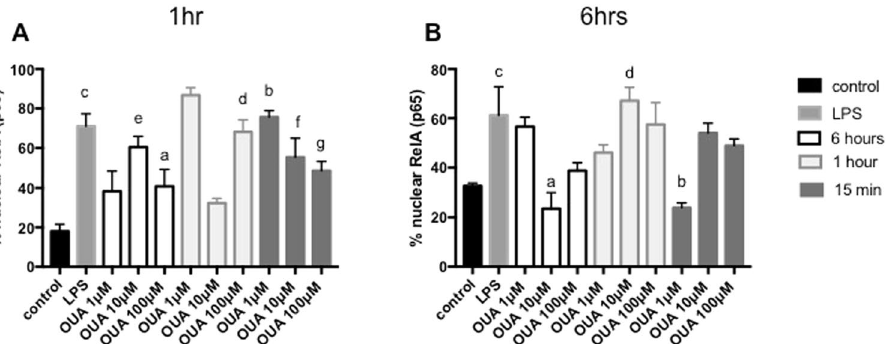
Figure 2. OUA decreases the nuclear translocation of RelA induced by LPS. ( A ) Glial cells were treated for 1 hour with LPS (1 µ g/mL) followed by OUA treatment at different times (15 minutes,1 hour and 6 hours) and concentrations (1–100 µ M) and were then stained with RelA antibody and DAPI. The results were calculated by the ratio of the number of cells with nuclear translocation of RelA to the total number of cells that were stained with DAPI (n = 4). a indicates p < 0.05 vs control, 10 µ M OUA at 1 hour, 1 µ M OUA at 6 hours, 100 µ M OUA at 6 hours, 100 µ M OUA at 15 minutes and 10 µ M OUA at 15 minutes; b indicates p < 0.05 vs control, 10 µ M OUA at 1 hour, 1 µ M OUA at 6 hours and 100 µ M OUA at 6 hours; c indicates p < 0.05 vs control, 10 µ M OUA at 1 hour, 1 µ M OUA at 6 hours and 1 µ M OUA at 6 hours; d indicates p < 0.05 vs control, 10 µ M OUA at 1 hour, 1 µ M OUA at 6 hours and 1 µ M OUA at 6 hours; and e, f, and g indicate p < 0.05 vs control. ( B ) Glial cells were treated for 6 hours with LPS followed by OUA treatment at different times (15 minutes, 1 hour and 6 hours) and concentrations (1–100 µ M) and stained with RelA antibody and DAPI (n = 4). The results were calculated as the ratio of the number of cells with nuclear translocation of RelA to the total number of cells that were stained with DAPI. a indicates p < 0.05 vs 10 µ M OUA at 1 hour, LPS, 100 µ M OUA at 1 hour, 1 µ M OUA at 6 hours and 10 µ M OUA at 15 minutes; b indicates p < 0.05 vs control, 10 µ M OUA at 1 hour, LPS, 100 µ M OUA at 1 hour, 1 µ M OUA at 6 hours and 10 µ M OUA at 15 minutes; c and d indicate p < 0.05 vs